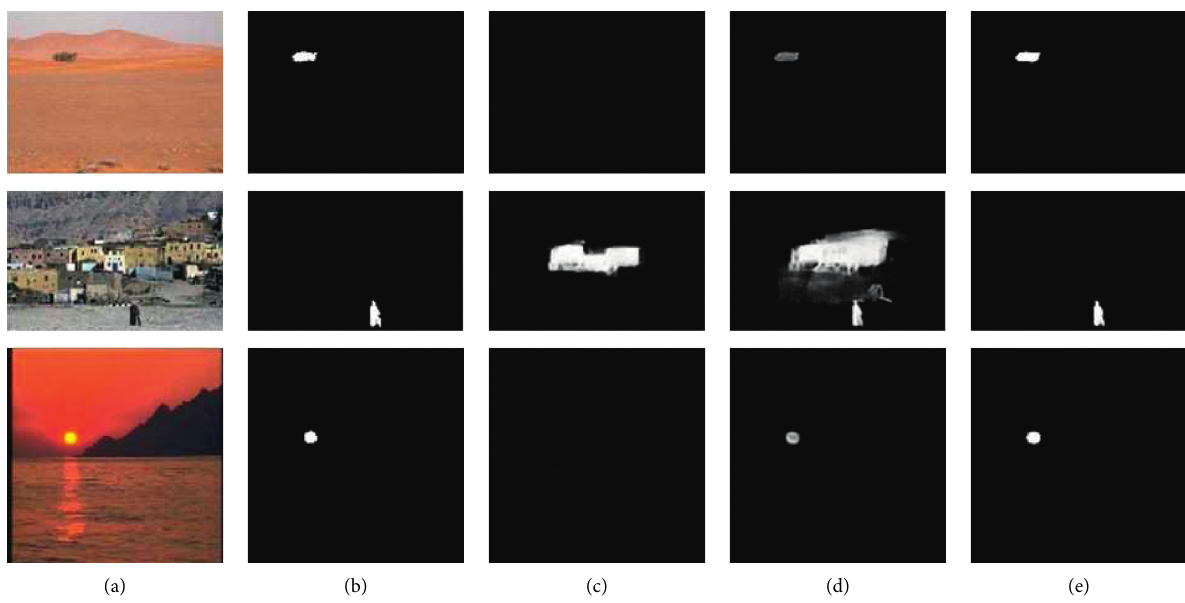
Figure 10: Visual comparisons for showing the proposed modules. M: the proposed M2Net with binary cross entropy loss; C: centerness; I: Intersection over Union. (a) Image. (b) GT. (c) M. (d) M+C. (e) M